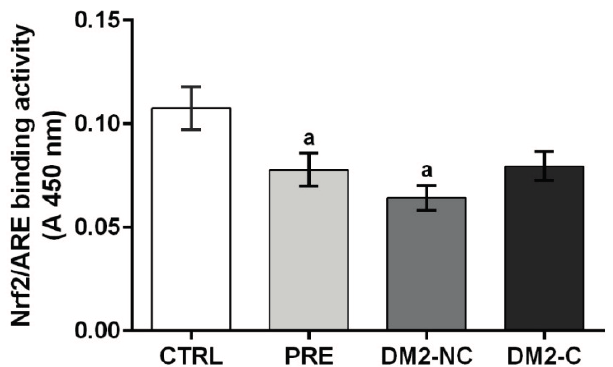
Figure 3. Nrf2/ARE binding activity assay: Nuclear proteins from CTRL: control subjects ( n = 100), PRE: prediabetic subjects ( n = 68), DM2-NC: diabetic subjects without glycemic control (Hb > 7.0%, n = 54), DM2-C: diabetic subjects with glycemic control ( n = 58) were incubated with the oligonucleotide for ARE (antioxidant response element). Each bar represents mean ± S.E. a Significant difference vs. CTRL with p < 0.05.